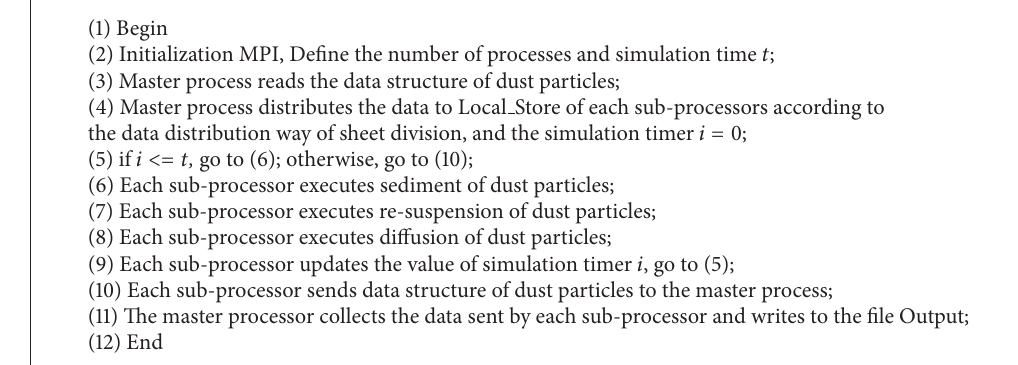
Algorithm 1: Frame of KMC-based dust evolution parallel simulation algorithm.